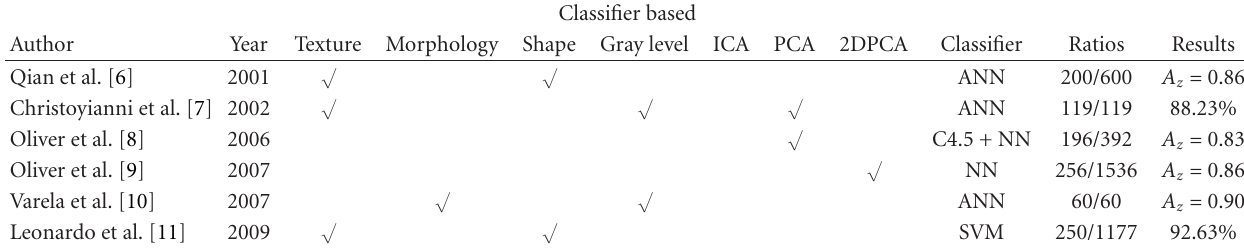
Table 1: Previously developed approaches on mass detection based on feature extraction and on learning. In this table, we specify for each approach the feature extraction technique, the classifier, the ratio which indicates the number of real masses/number of normal ROIs, and the obtained results. In the feature extraction methods, ICA, PCA, and 2DPCA correspond, respectively, to independent component analysis, principal component analysis and two-dimensional PCA. In the classification stage, ANN, NN, and SVM correspond, respectively, to the artificial neural network, nearest neighbors, and support vector machines. Generally, the evaluation of the works is given in terms of A z where A z represents the area under the ROC curve, except for both works of Christoyianni et al. and Leonardo et al. giving the correct classification true positive and true negative in